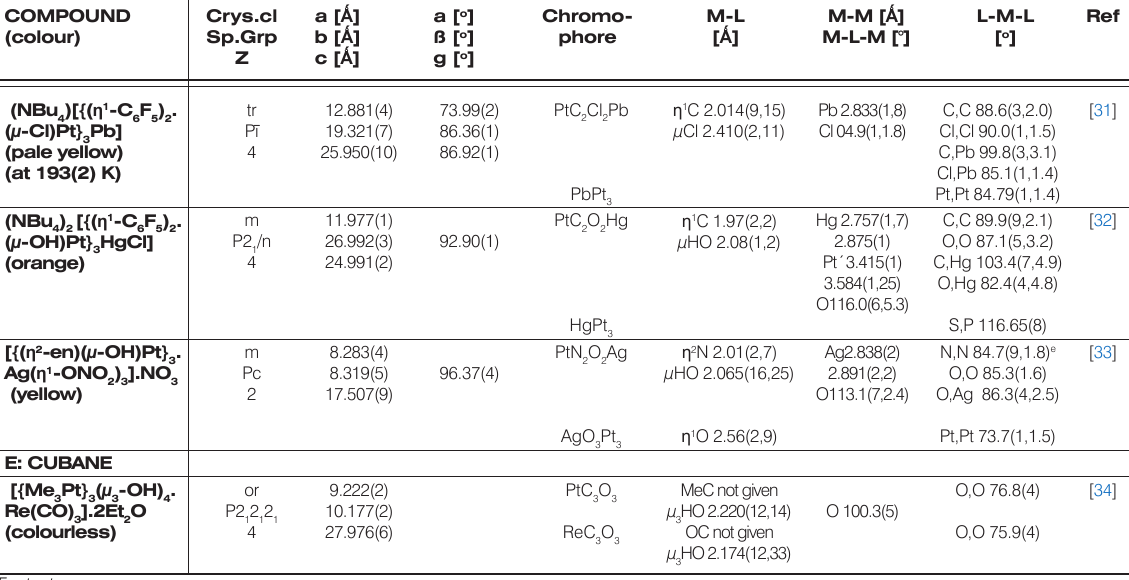
b. The chemical identity of the coordinated atom or ligand is specified in these columns. c. The six-membered metallocyclic ring. d. There are two crystallographically independent molecules. e. The five-membered metallocyclic